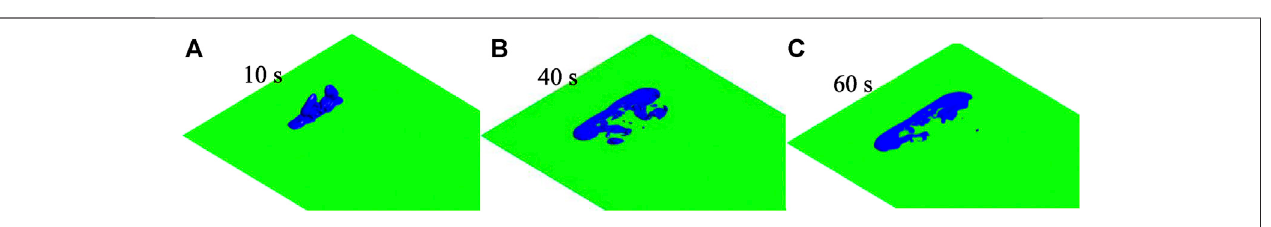
FIGURE 8 | CD-4 at different times (case3).